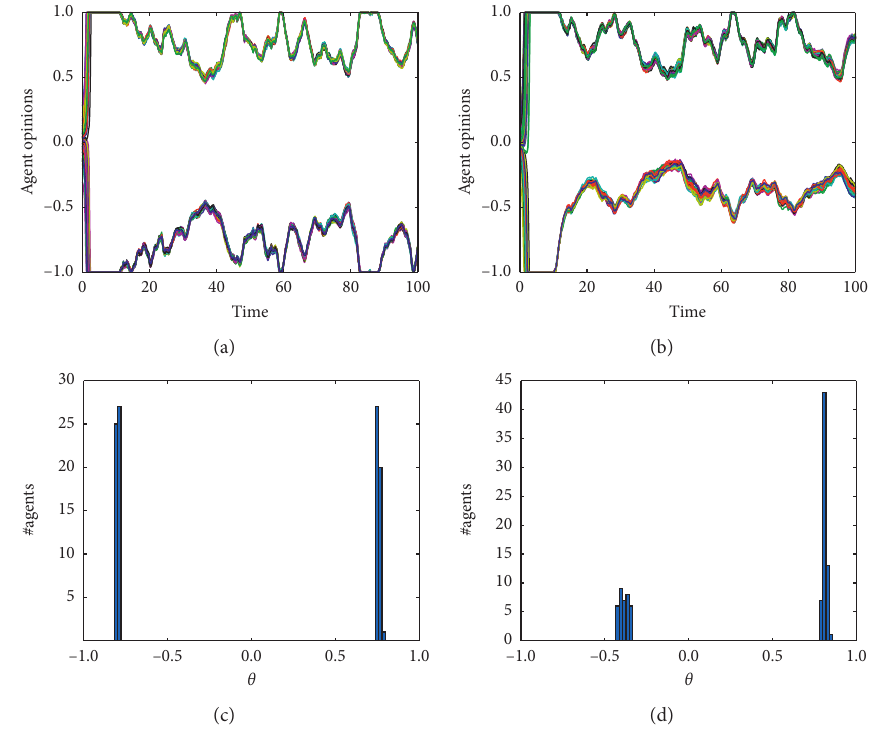
Figure 4: (a, b) Opinion trajectories. (c, d) Opinion distribution at t � 100. (a, c) α